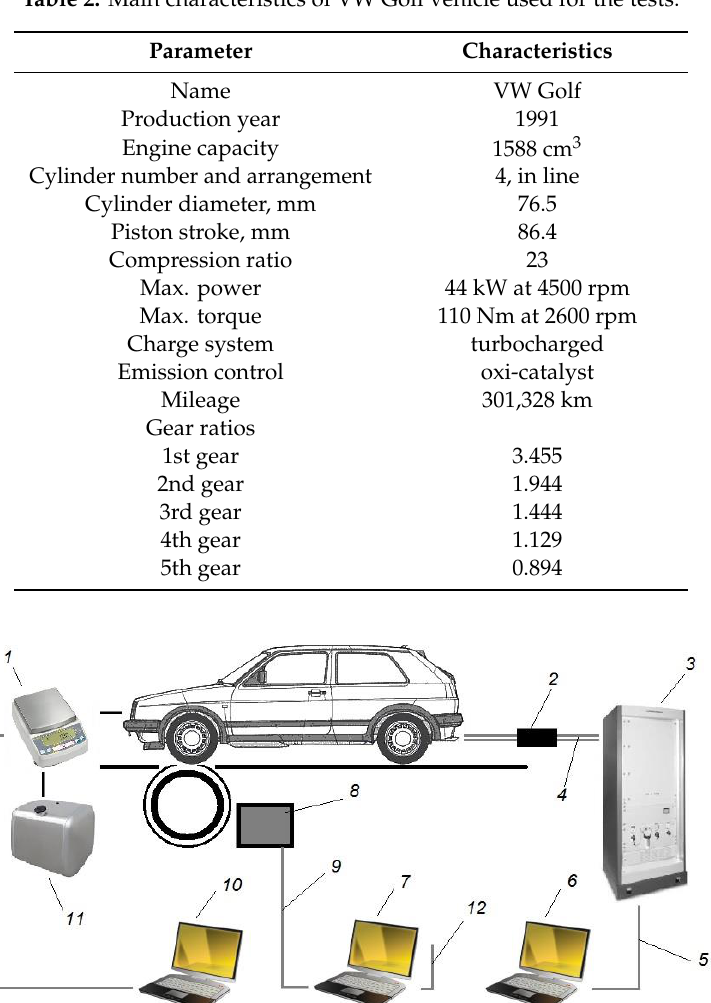
Table 2. Main characteristics of VW Golf vehicle used for the tests.